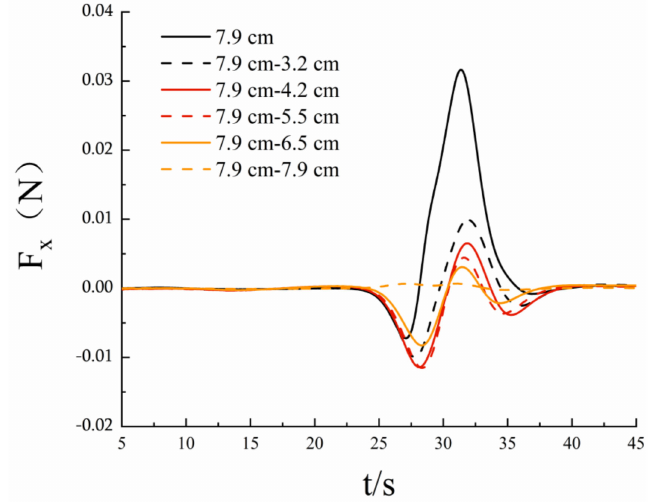
Figure 11. Horizontal force comparison of riser.